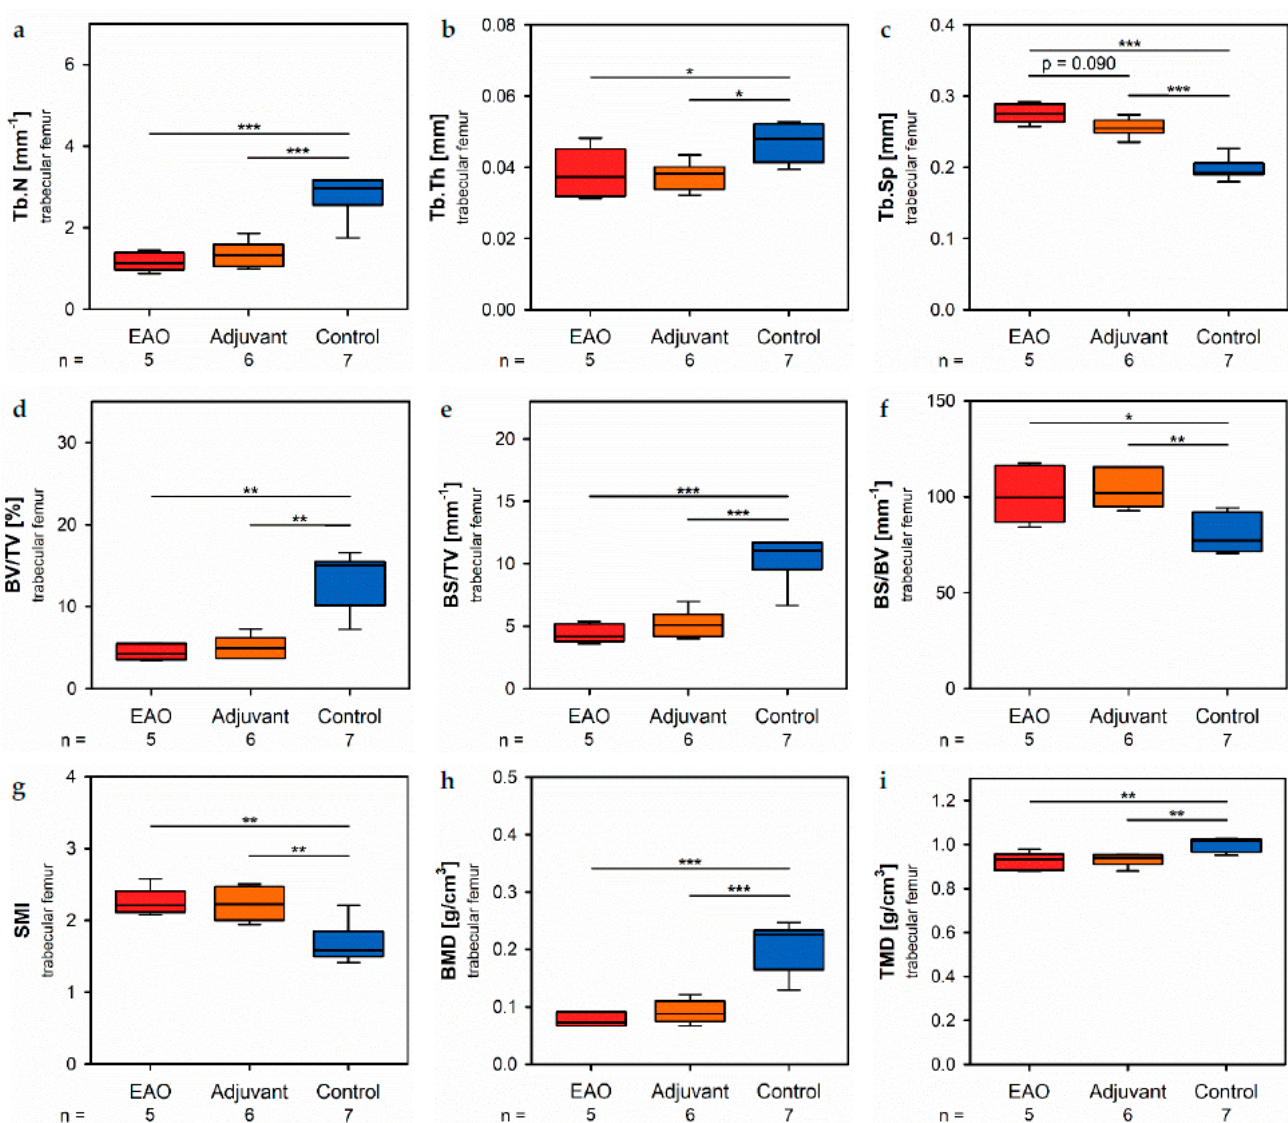
Figure 7. Microarchitecture of trabecular femur by µCT. Measurement of ( a ) trabecular number (Tb.N), ( b ) trabecular thickness (Tb.Th), ( c ) trabecular separation (Tb.Sp), ( d ) bone volume fraction (BV/TV), ( e ) bone surface density (BS/TV), ( f ) specific bone surface (BS/BV), ( g ) structure model index (SMI), ( h ) bone mineral density (BMD) and ( i ) tissue mineral density (TMD). Mice were immunized with testicular homogenate in adjuvant (EAO), adjuvant alone (adjuvant) or remained untreated (control). * p < 0.05; ** p < 0.01; *** p < 0.001.